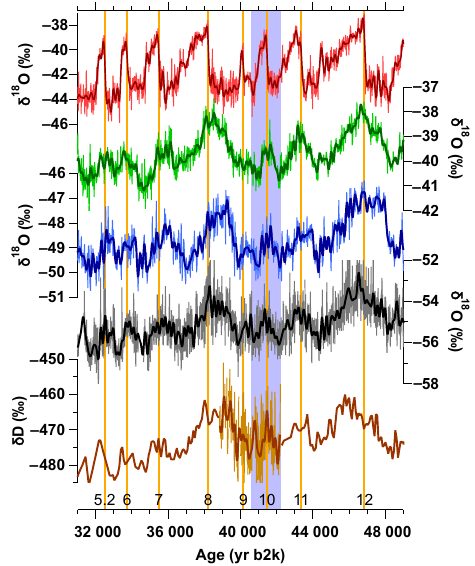
Figure 7. Water isotopic records for NGRIP and four Antarctic ice cores over DO events 5 to 12 on the GICC05 timescale with the tran- sition between GS and GIS indicated by the vertical orange lines. The synchronization between NGRIP (red), EDML (blue), EDC (black) and Vostok (brown) is based on the AICC2012 timescale, while the WDC (green) record has been transferred on the GICC05 timescale as WD2014 in Buizert et al.